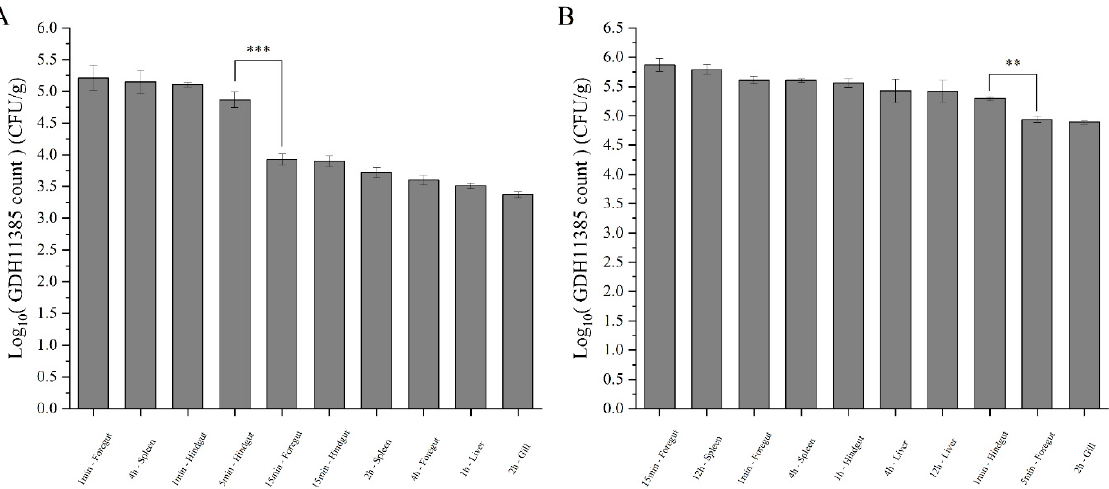
Figure 5. Comparison of maximum GDH11385 burden in brain, liver, spleen, head kidney, gills, foregut, hindgut and heart over 48 h postinjection. ( A ) Ten data with the maximum GDH11385 burden in group D; ( B ) ten data with the maximum GDH11385 burden in group E. Data are shown as mean ± SD of three independent biological replicates. ** p < 0.01, *** p < 0.001.